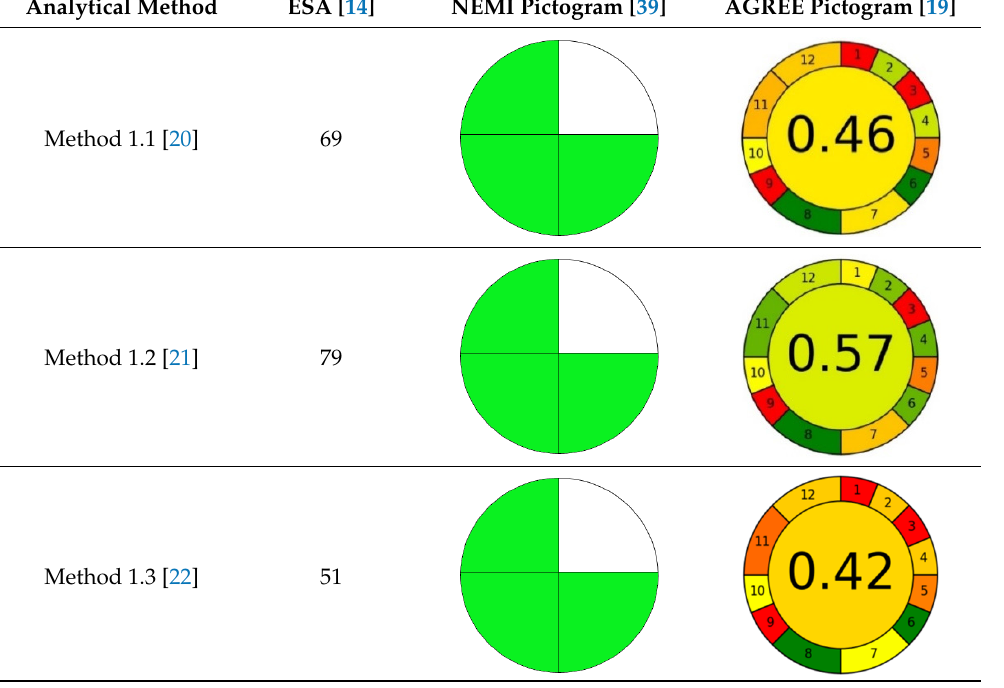
Table 1. Greenness assessment results of methamphetamine and captagon analytical procedures.